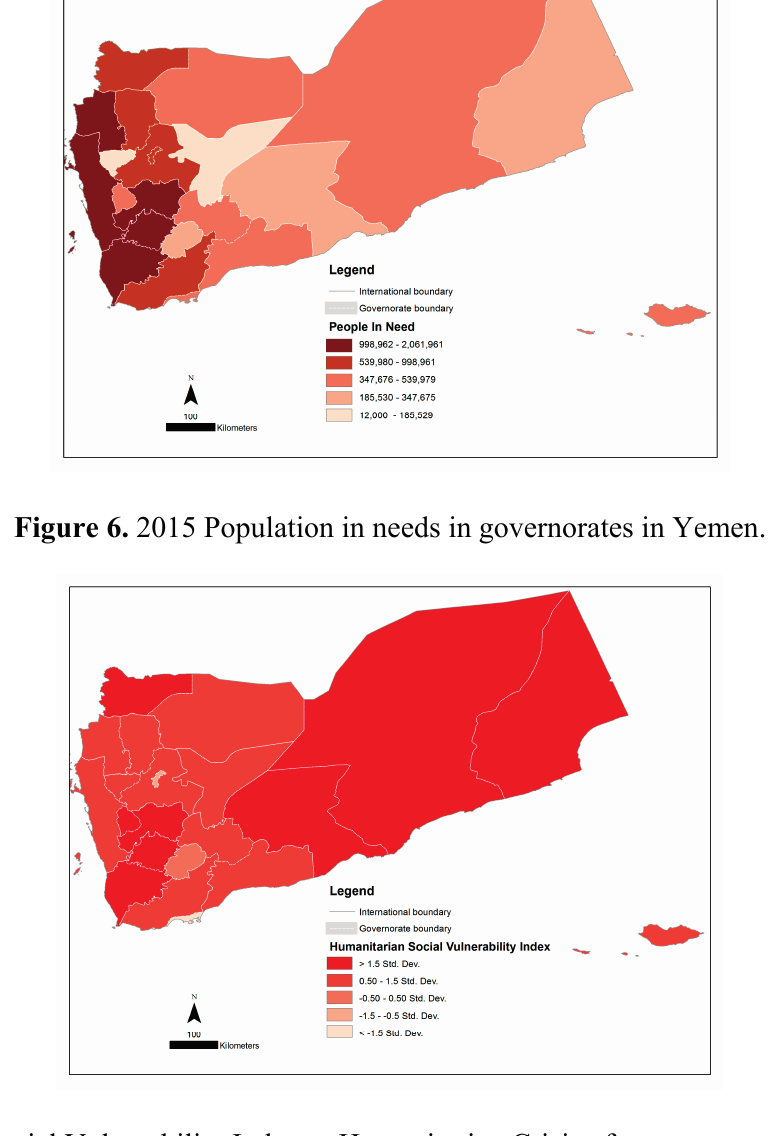
Figure 7. Social Vulnerability Index to Humanitarian Crisis of governorates